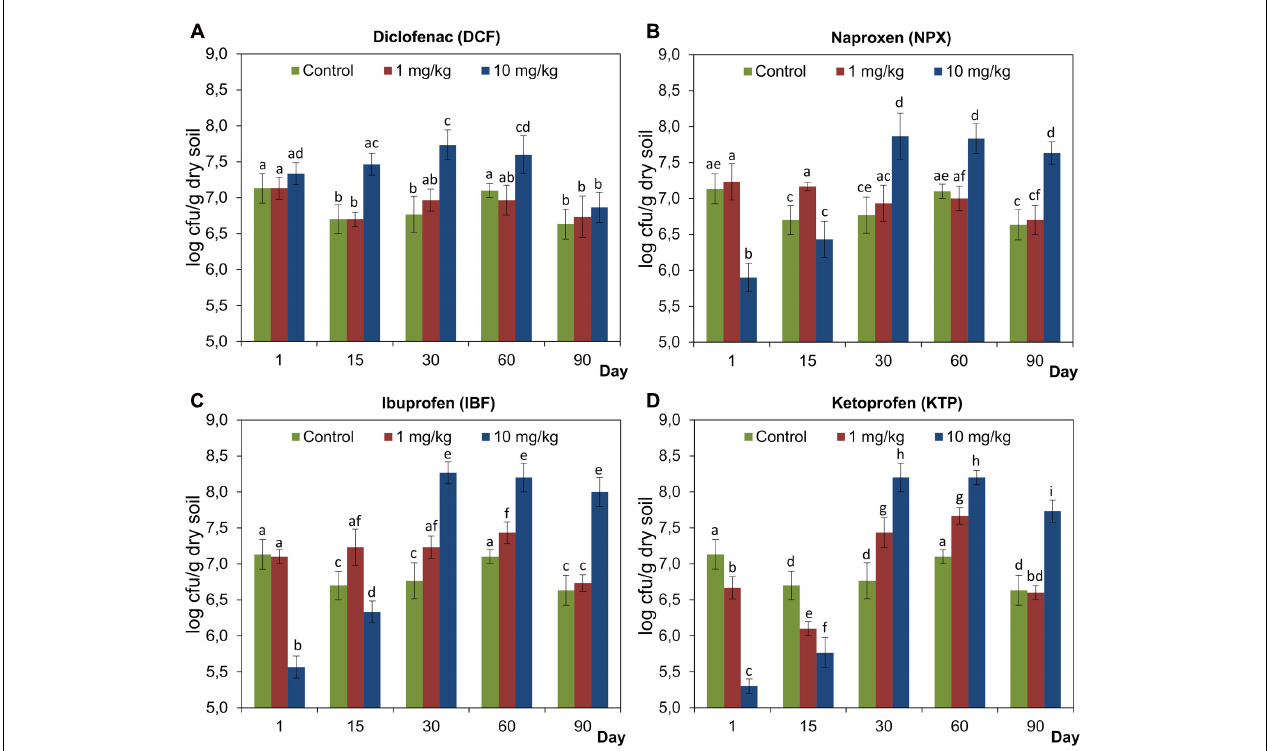
FIGURE 9 | The total number of culturable bacteria in control soil and soil treated with diclofenac (A) , naproxen (B) , ibuprofen (C) , and ketoprofen (D) at concentrations of 1 and 10 mg/kg soil during the 90-day experiment. The data presented are the means and standard deviations of three replicates and are expressed as log cfu/g dry soil. Different letters (within each drug) indicate significant differences ( P < 0.005, LSD test) related to the effects of concentration and